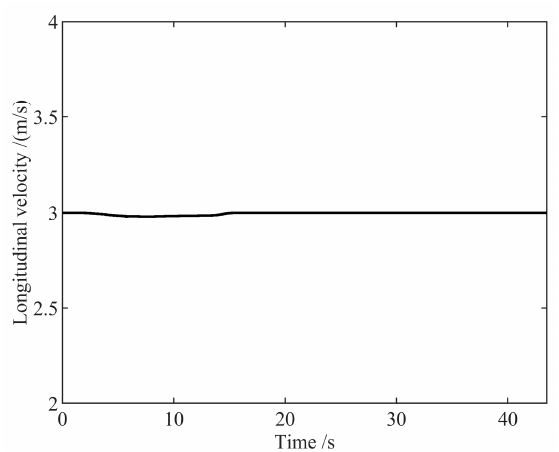
Figure 25. Longitudinal velocity in the third group of simulations.